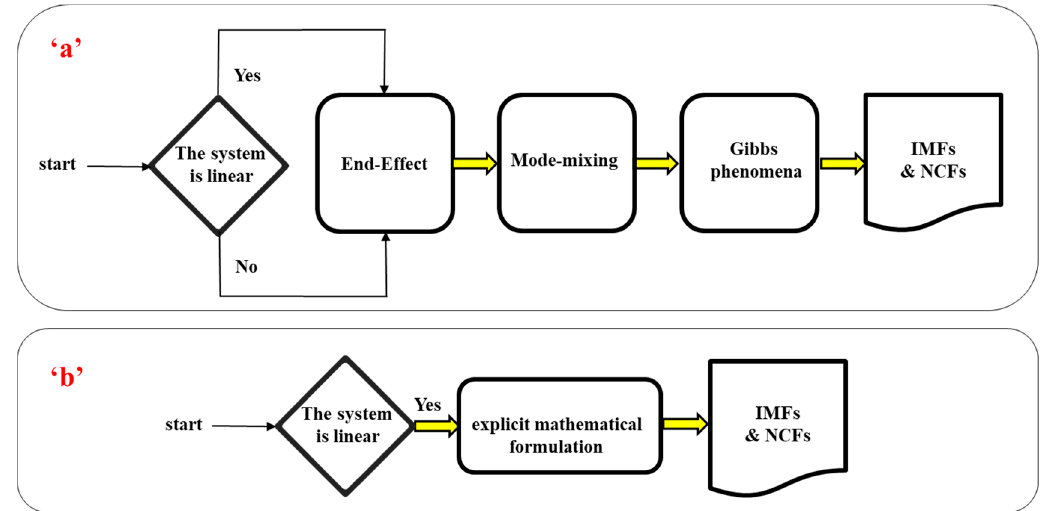
Figure 3. General outline of (a) Hilbert–Huang transform (HHT) method; (a) proposed method;.